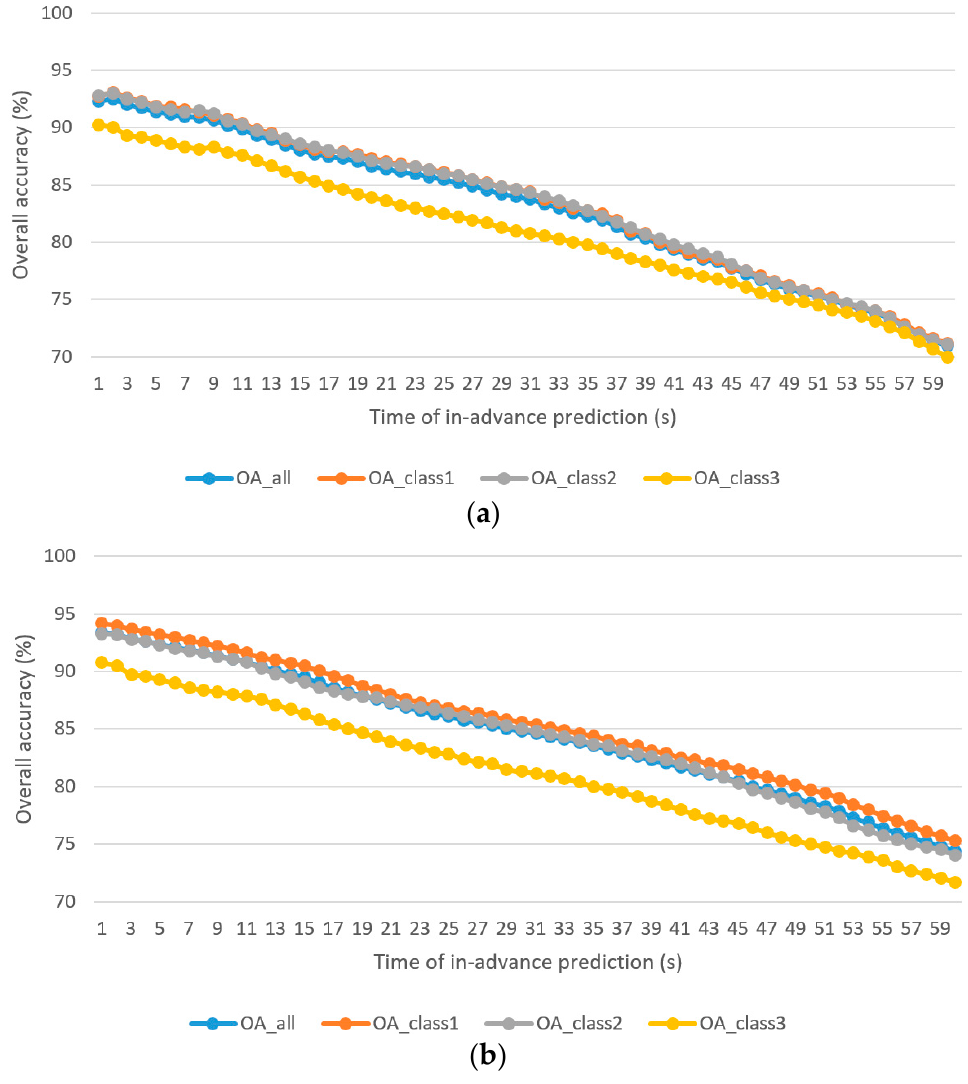
Figure 4. Overall accuracy in each class of the prediction models based on the NSGA-III optimized RNN-GRU-LSTM algorithm: ( a ) driver stress prediction; ( b ) driver drowsiness prediction.